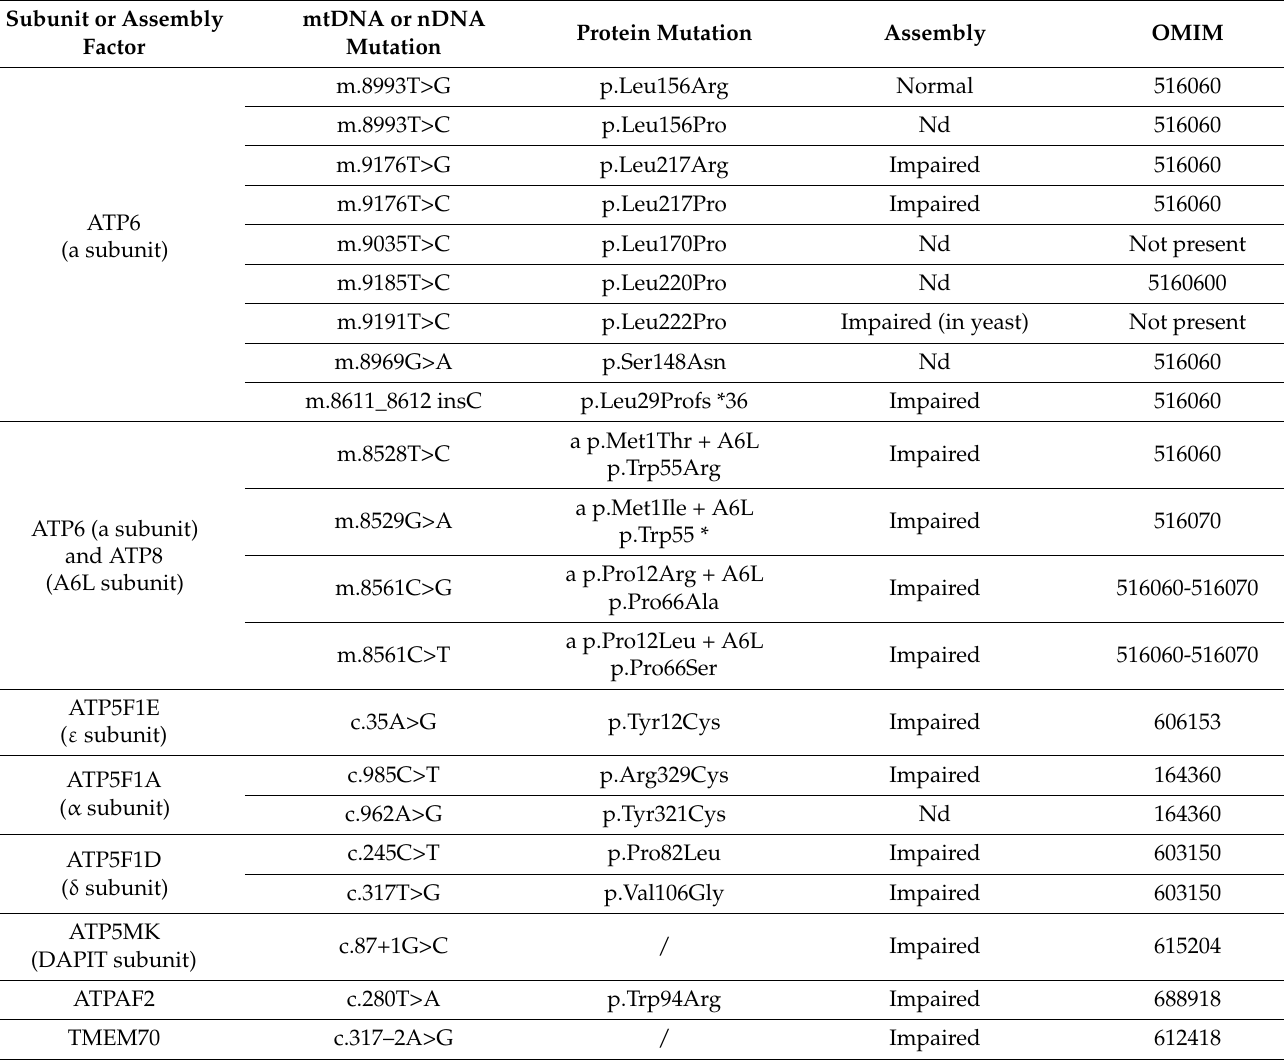
Table 5. Mutations in nuclear and mitochondrial genes associated with mitochondrial complex V deficiency. Adapted and modified from [52] under the Creative Commons Attribution (CC BY) license. * indicates a STOP